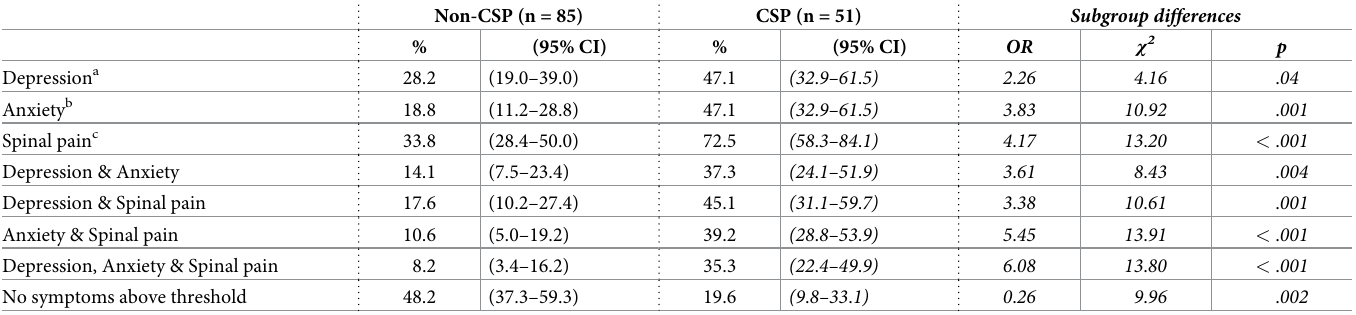
Table 3. Prevalence’s of clinical depression a , anxiety b and spinal pain c and of simultaneous occurrences of symptoms at two-year follow-up. Statistics are stratified for the presence of